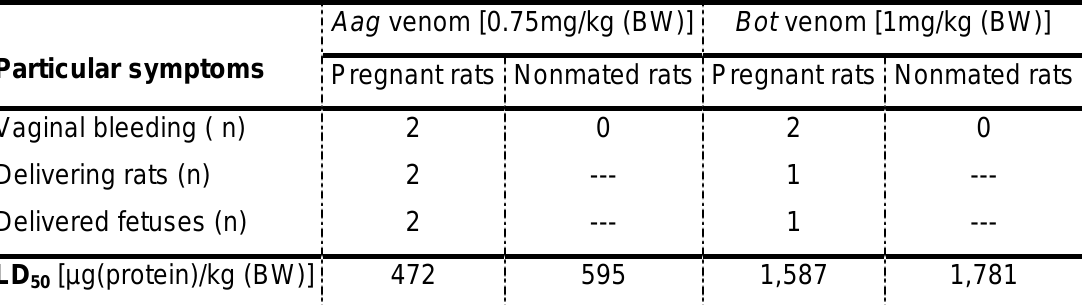
Table 1. Particular toxicity symptoms and median lethal dose (LD occitanus tunetanus ( Bot ) and Androctonus australis garzoni ( Aag ) venoms in pregnant and non-pregnant